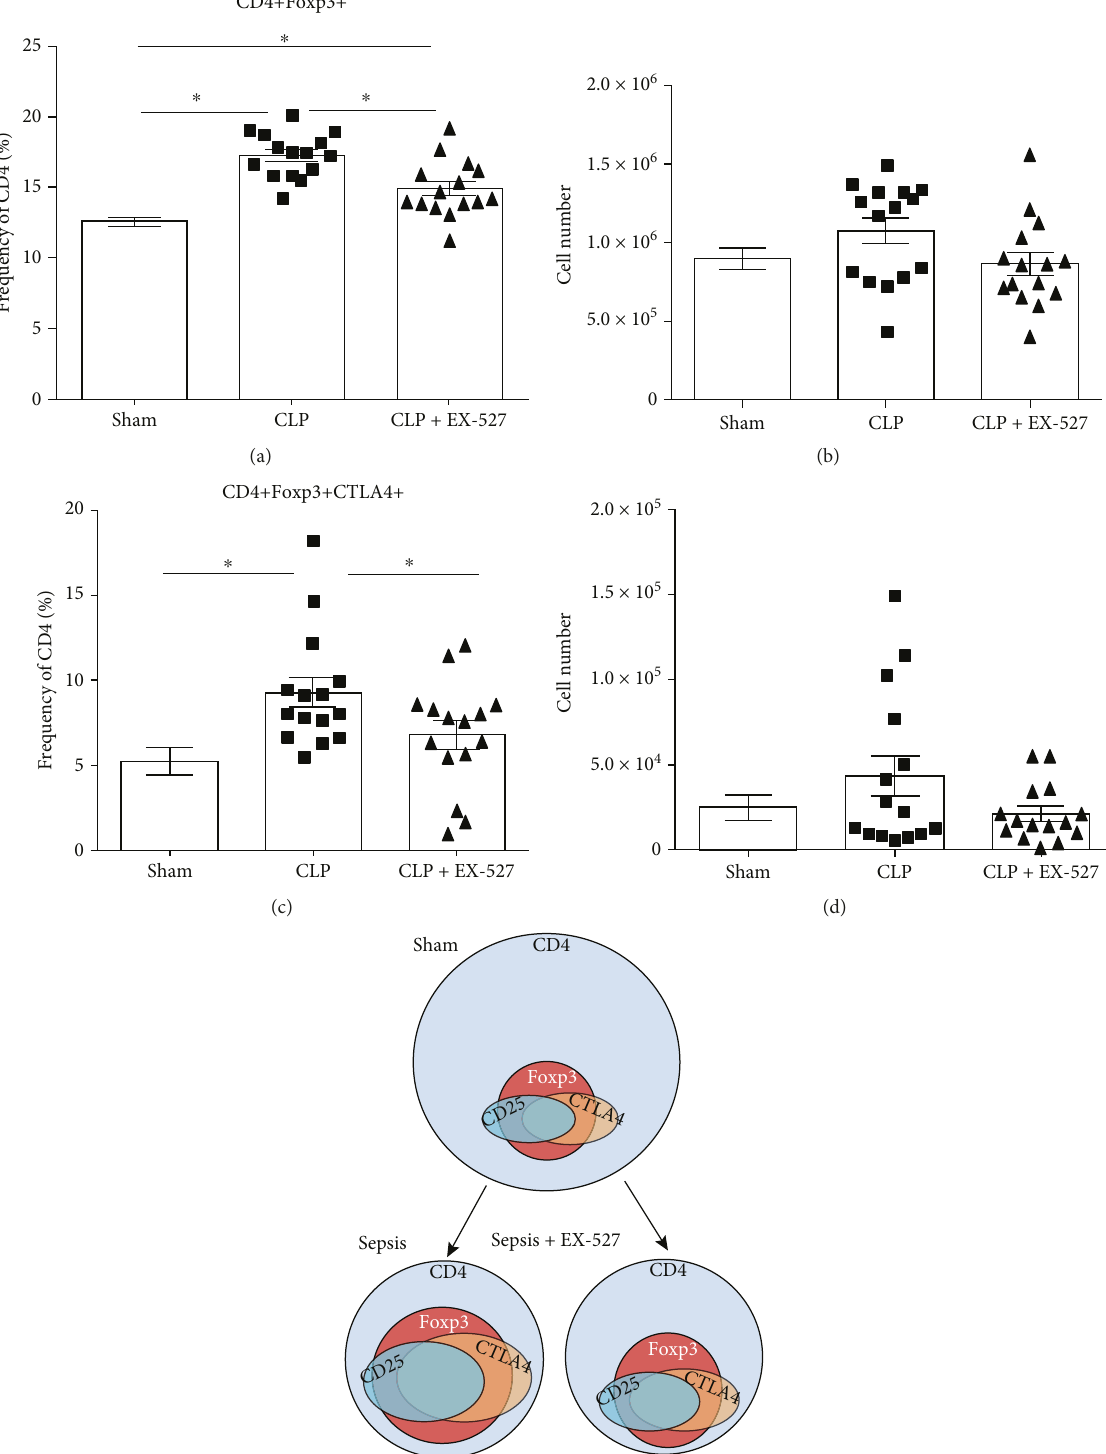
Figure 3: The frequency of CD4+Foxp3+ T cells reversibly increases in sepsis with SIRT1 inhibition. Cumulative results of CD4+Foxp3+ Reg T cells presented as (a) frequency of CD4 (%) and (b) absolute cell count. Cumulative results of CD4+Foxp3+CTLA4+ T Reg as (c) frequency of CD4 (%) and (d) absolute cell count. (e) Representative fi gure of the ratio changes in population size of CD4+ T cells and CD4+ T subpopulation. Markers are not representative of surface versus intracellular location. Data are representative of three Reg independent analyses with a total of 5 mice in each group. Data are expressed as mean ± SEM. n = 15 mice/group. ∗ p < 0 05